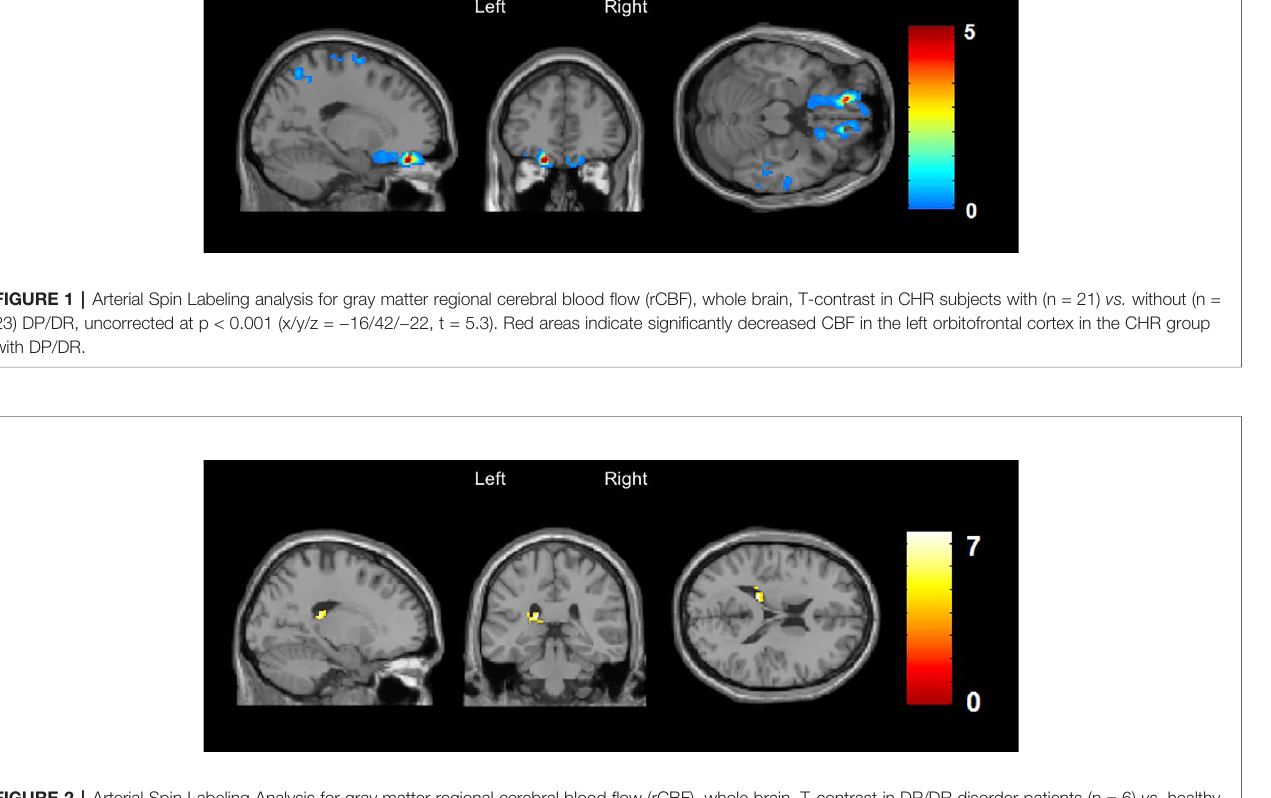
FIGURE 2 | Arterial Spin Labeling Analysis for gray matter regional cerebral blood fl ow (rCBF), whole brain, T-contrast in DP/DR disorder patients (n = 6) vs. healthy controls (n = 6), uncorrected at p < 0.001 (x/y/z = − 60/ − 44/ − 20, t = 6.7). Yellow areas indicate signi fi cantly increased CBF in the left caudate nucleus in DP/DR as compared to controls.